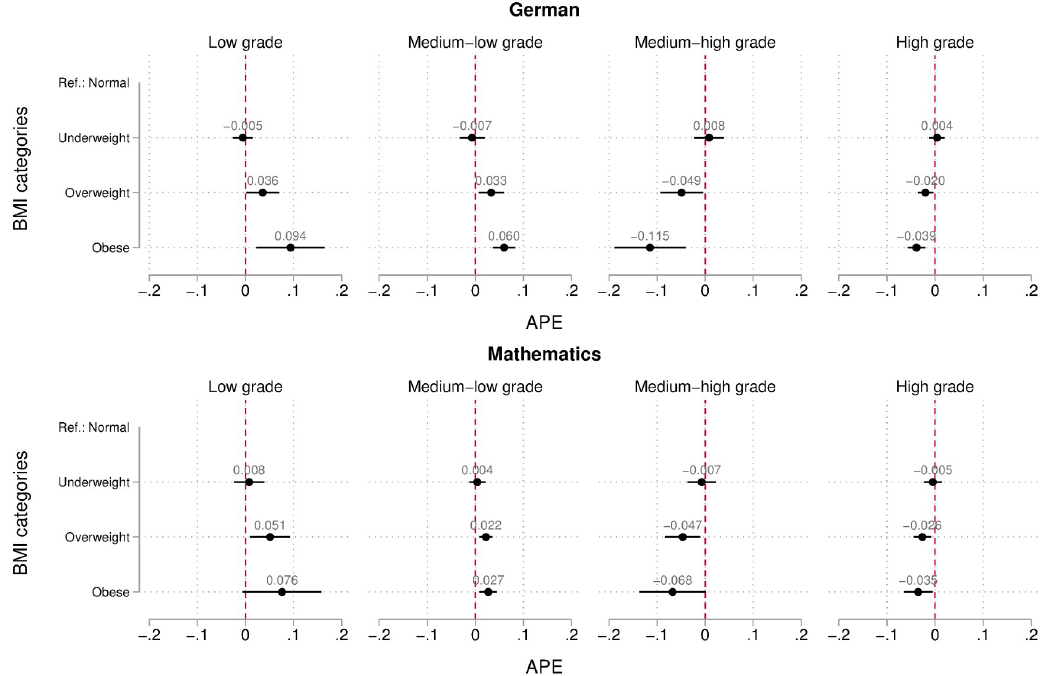
Fig 3. Teachers’ grading bias (measured in average partial effects) according to students’ BMI. The graph shows average partial effects from the 3-level hierarchical ordered logit model on mathematics grades (upper part) and German (lower part). Bars represent 95% confidence intervals. The models are adjusted for students’ competence level, socio-demographic characteristics, psychological traits, and school-related attitudes and behavior. N = 3,754. Analysis conducted on 50 multiply imputed